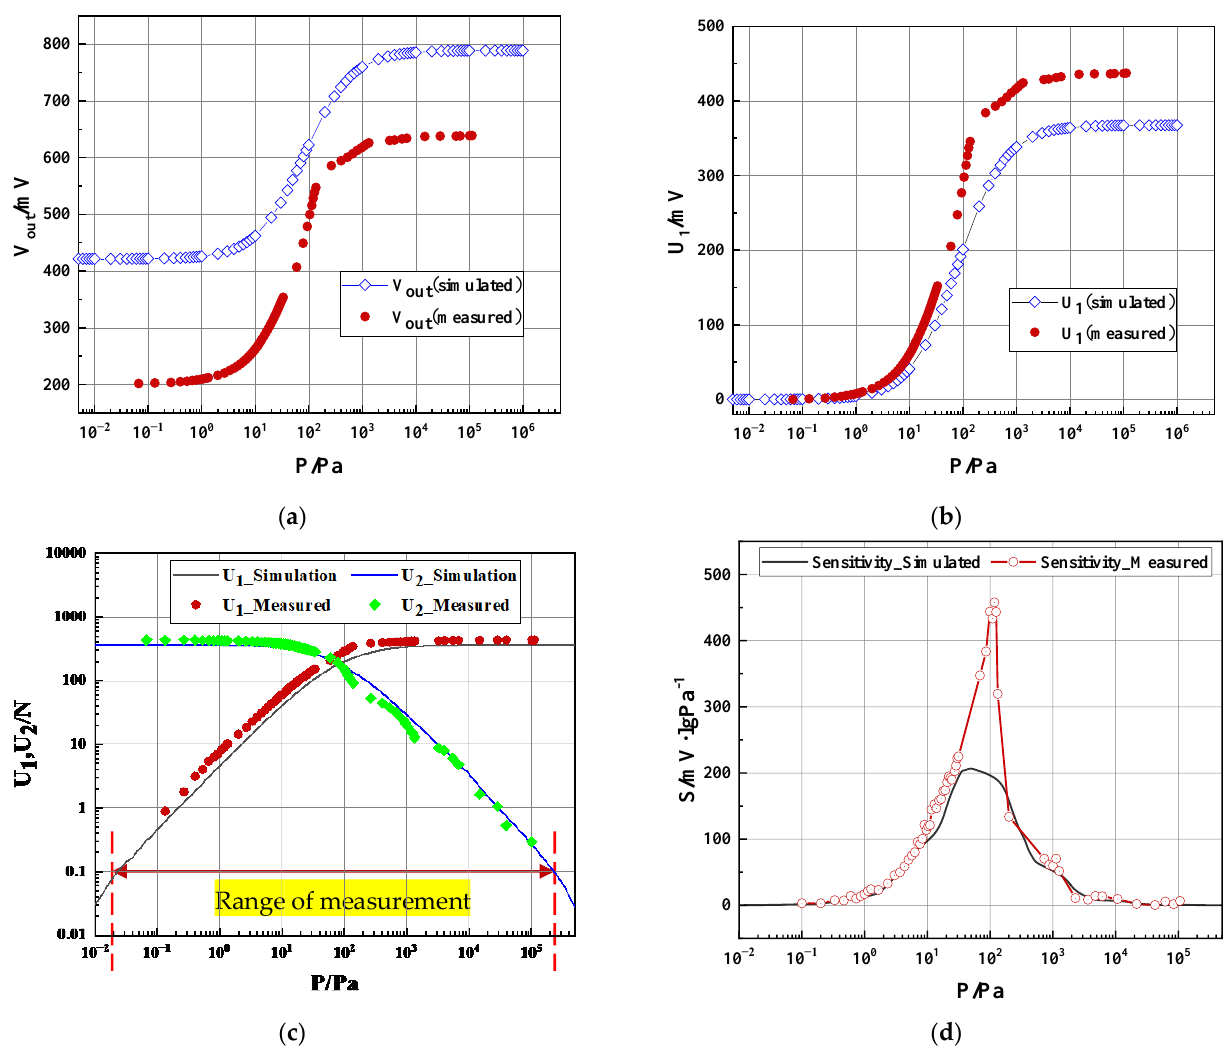
Figure 10. Performance of the Pirani gauge (experiment and simulation) . ( a ) Raw data of circuit outputs together with the simulation results. ( b ) U 1 curves. ( c ) Analysis of ranges of measurement. ( d ) Analysis of sensitivity.